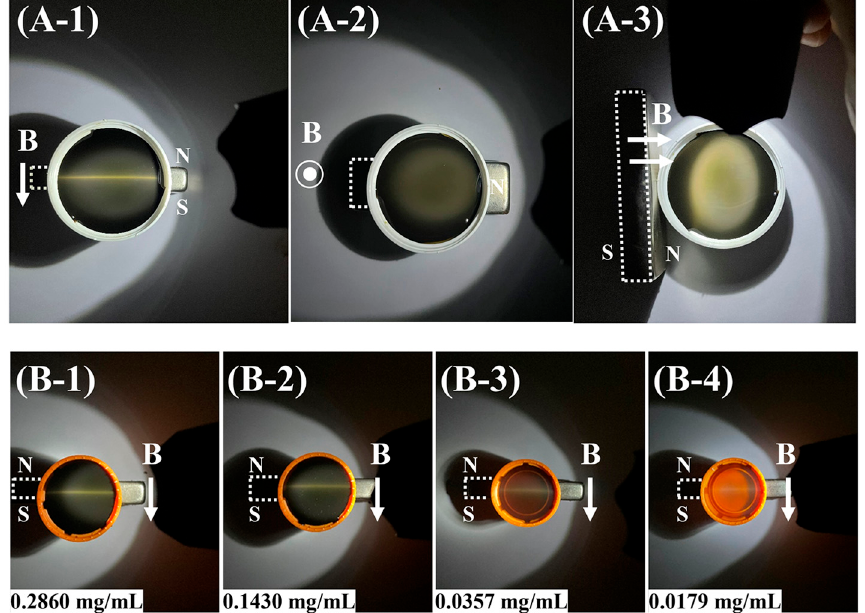
Figure 15. Real images of the GO@Fe 3 O 4 sol Bragg reflections ( A-1 – A-3 ) under various magnetic field directions and ( B-1 – B-4 ) with various solid content of GO@Fe 3 O 4 sol in the magnetic field. (The B shows the direction of the magnetic